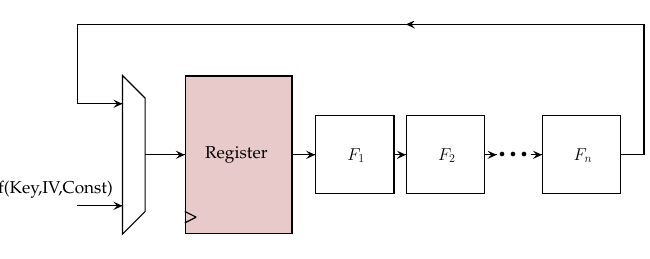
Figure 1: n round unrolled implementation of a stream